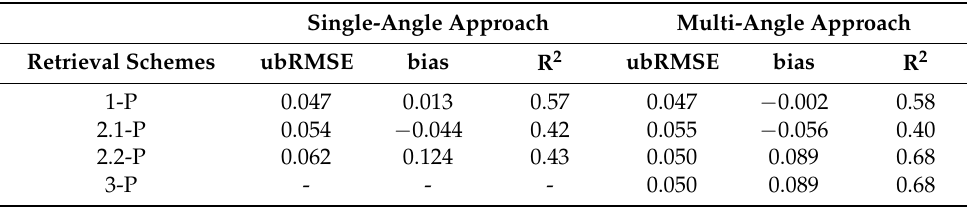
Table 3. Summary of the comparison between the measured and modeled volumetric soil water content ( SWC ) (m 3 m − 3 ) for the different retrieval schemes. Unbiased root-mean-square-error (ubRMSE), bias, and coefficient of determination (R 2 ) values are